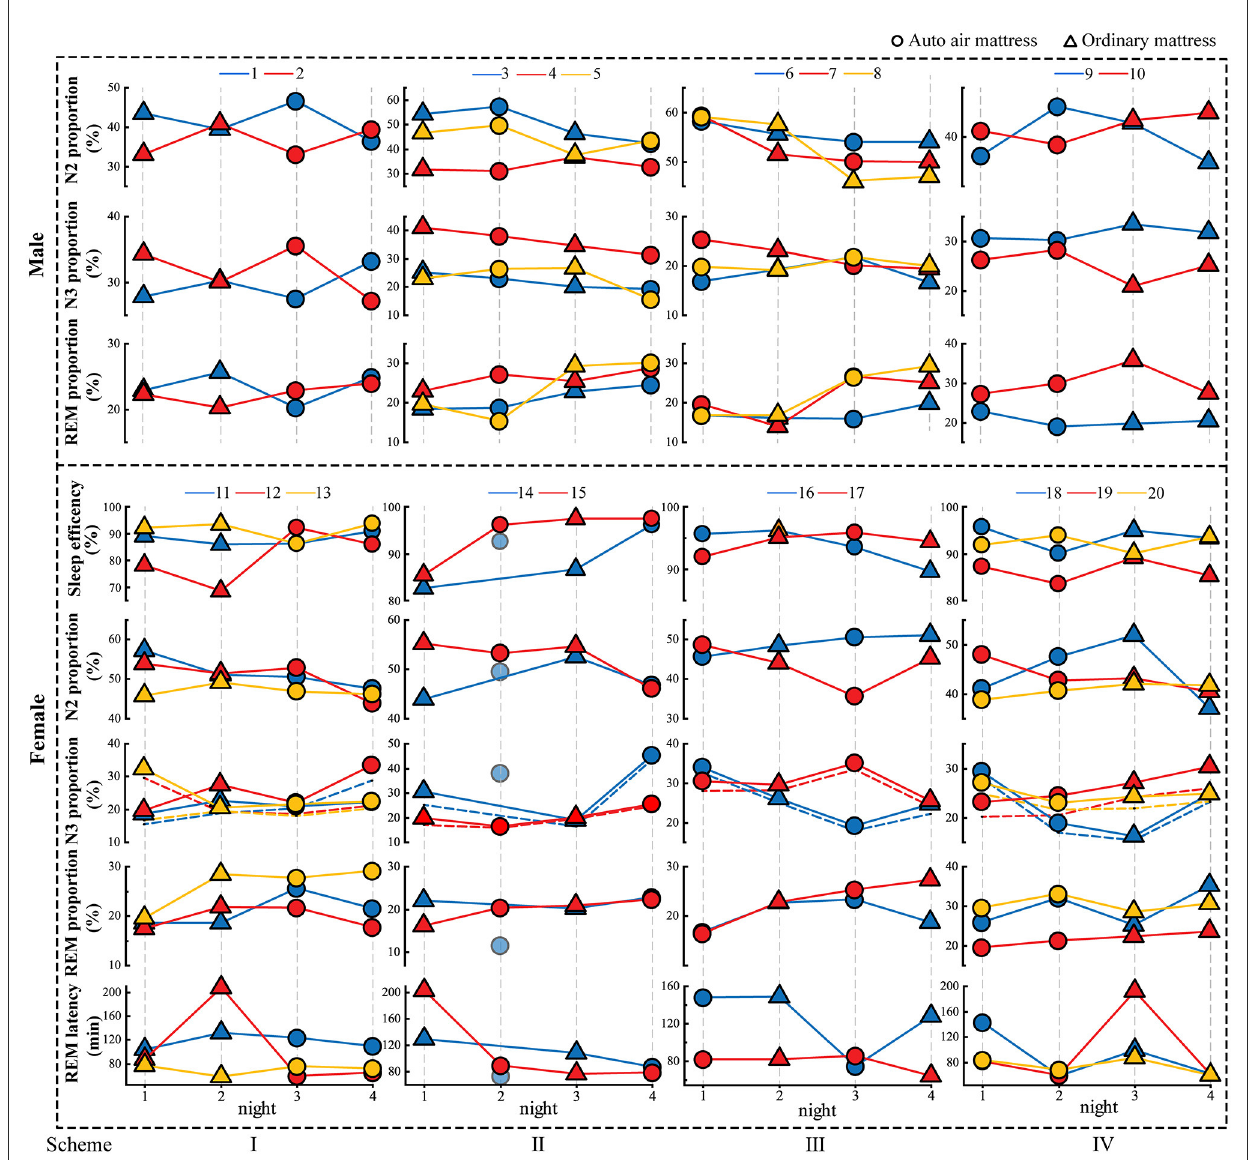
FIGURE4 The objective evaluation parameters of the participants. The numbers 1 to 20 are the number of participants. The dashed line in N3% of female participants is the ratio of N3 sleep to the time of recording. The second night of No.14 was only recorded for nearly